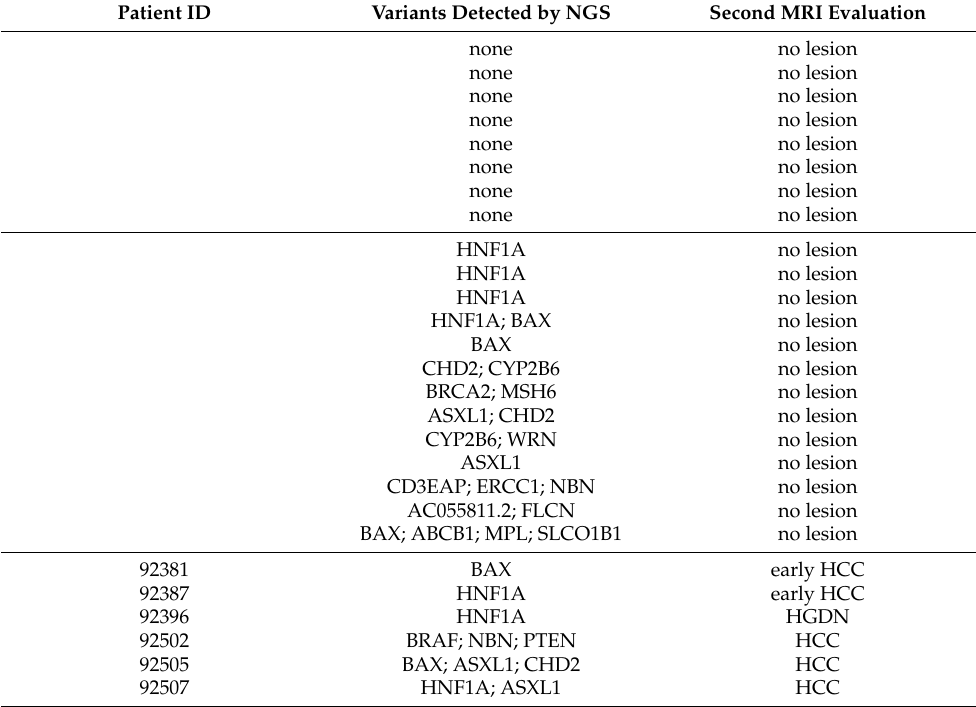
Table 4. Distribution of variants among the patients who received an MRI. Twenty-seven patients